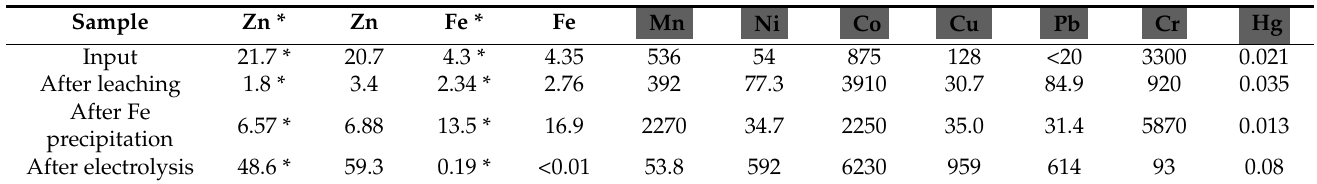
Table 9. Results of chemical analyses of solid samples (Zn and Fe in wt.%; other elements marked with grey color in wt. ppm)—an average of three measurements (supplier H21).